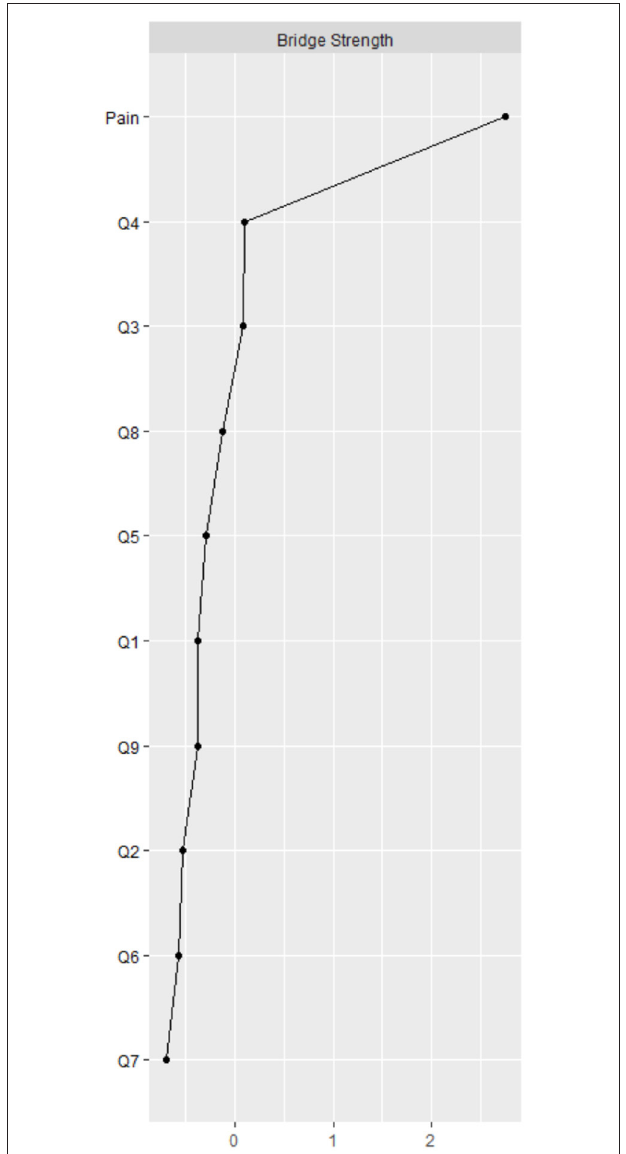
FIGURE 3 | Bridge centrality indices of network. Q = question from the Patient Health